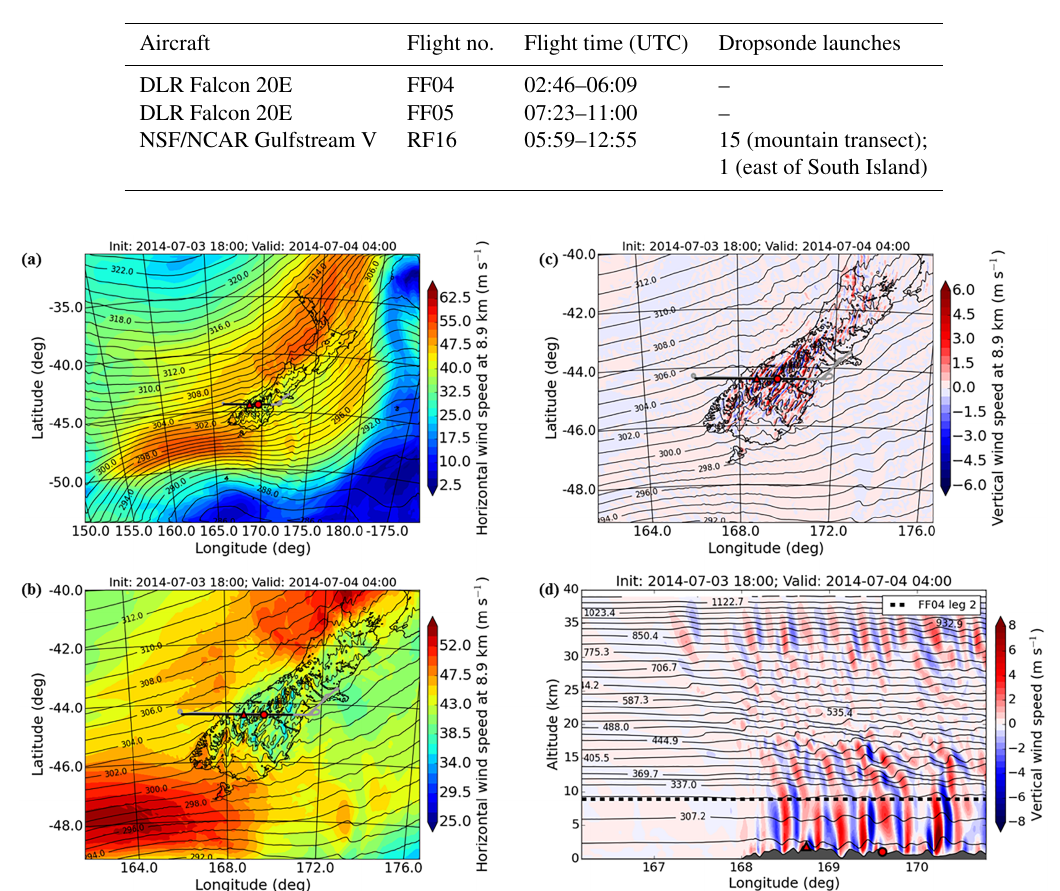
Figure 1. Synoptic situation on 4 July 2014 at 04:00UTC simulated by WRF: (a) horizontal wind speed at 8.9km (altitude of DLR Falcon flight FF04 leg 2) for New Zealand, (b) horizontal wind speed over the South Island of New Zealand (zoom of a ), (c) vertical wind speed at 8.9km over the South Island of New Zealand and (d) cross section of the vertical wind speed along the flight leg. Contour lines represent the potential temperature at 8.9km (a–c) and over the altitude (d) . The thick black line in (a) – (c) displays the cross-mountain flight path and the grey line shows the whole flight path of the DLR Falcon flight FF04. The thick black dashed line in (d) indicates the altitude of the second flight leg of FF04 and the grey area at the bottom displays the topography. The red dot in all panels marks the position of the dropsonde launch from the GV at 08:00UTC (see Fig. 7) and the red triangle marks the position of Mount Aspiring.